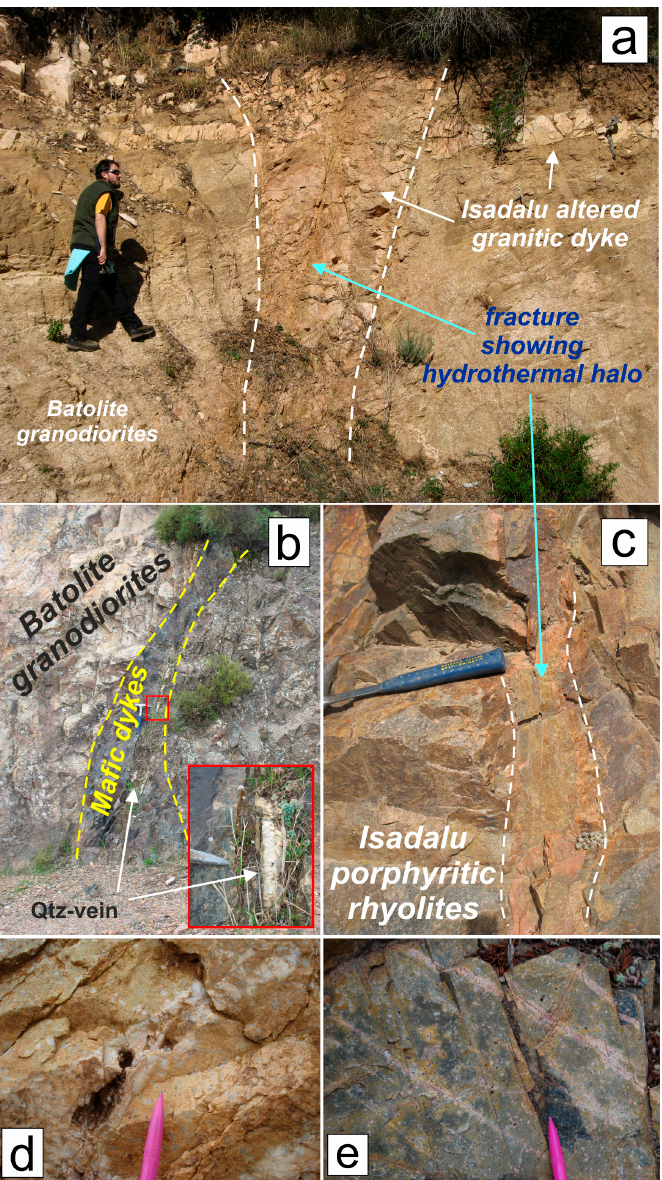
Figure 5. Field photographs of veins and hydrothermal fractures in Isadalu magmatic complex: ( a ) major fracture showing hydrothermal halo cutting metric Isadalu granitoid dyke; ( b ) mafic dyke cut by late Qz-vein, in the red rectangle a close-up field photograph; ( c ) fracture with hydrothermal halo in Isadalu porphyritic rhyolites; ( d ) late Qz-vein cutting the Isadalu granitoid body; ( e ) Ep + Chl veins with associated alteration halo, cutting the Isadalu porphyritic rhyolites.